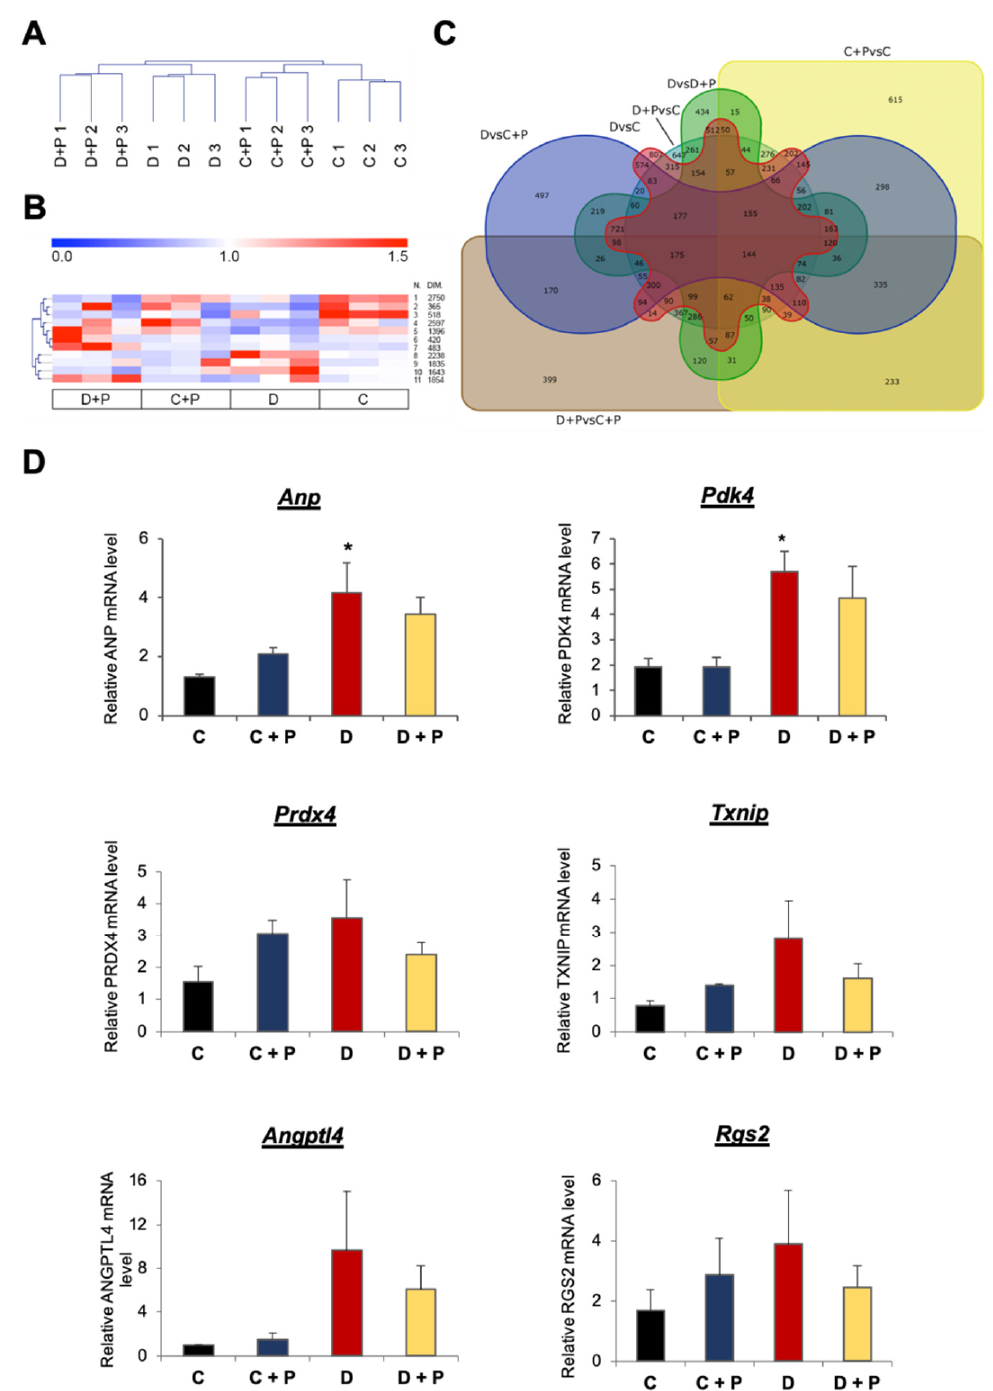
Figure 1. mRNA gene expression. ( A ) Dendrogram describing relationship of samples obtained according to mRNA gene expression. ( B ) Clusters of differentially expressed genes. Gene expression was calculated in relation to the average expression of the gene in all samples. ( C ) Venn diagram describing the number of differentially expressed mRNA for each comparison. ( D ) Validation of the mRNA microarray through qRT-PCR. mRNA levels were normalized to the housekeeping gene Tbp. * p ≤ 0.05 vs. C. C: control; C + P: control + pargyline; D: diabetes; D + P: diabetes + pargyline; Anp : atrial natriuretic peptide; Pdk4 : pyruvate dehydrogenase kinase 4; Prdx4 : peroxiredoxin 4; Txnip : thioredoxin interacting protein; Angptl4 : angiopoietin-like 4; Rgs2 : regulator of G-protein signaling 2.